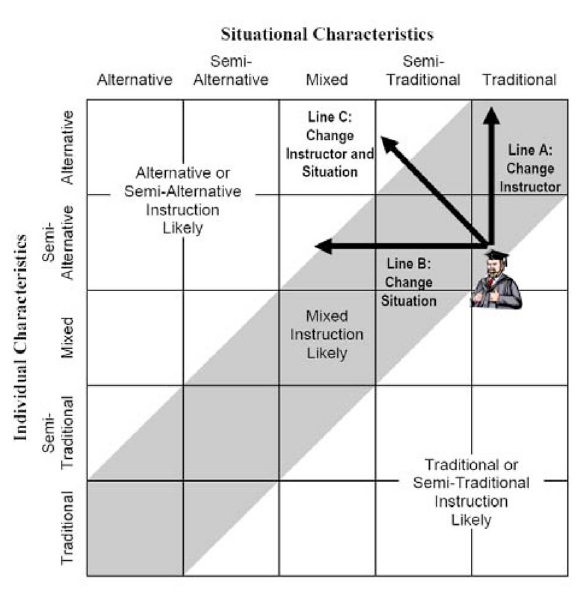
FIG. 2. (cid:1) Color (cid:2) Examination of change strategies using the toy